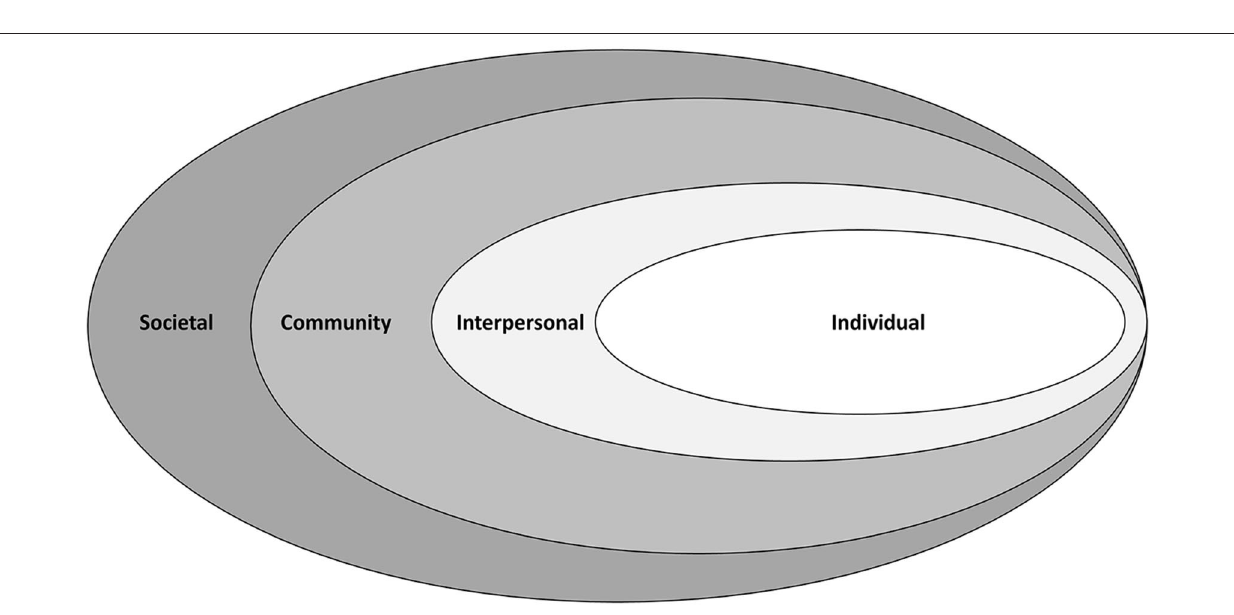
FIGURE 2 | Social-ecological model of violence prevention (from Centers for Disease Control and Prevention,